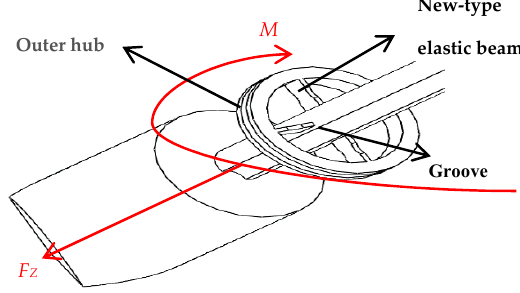
Figure 3. Force analysis of axial force FZ and torque M.